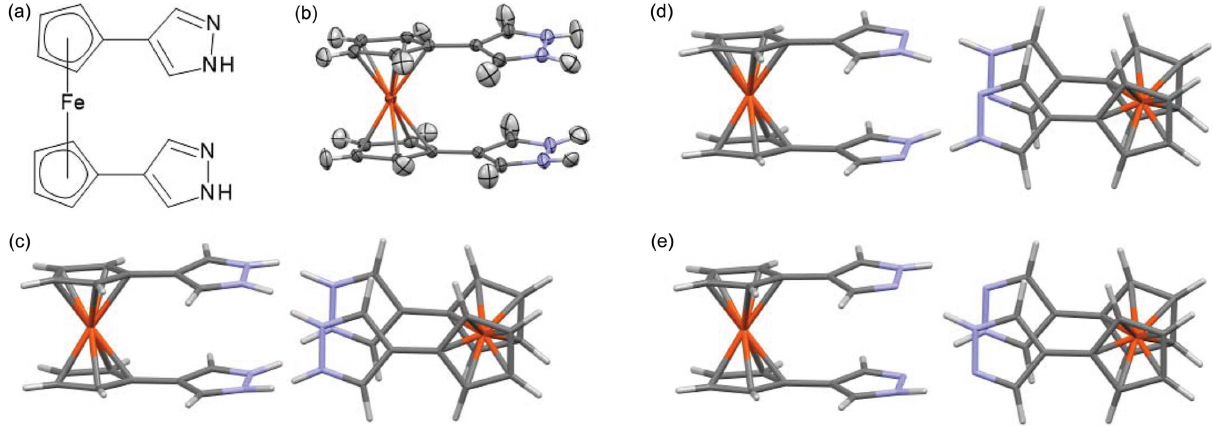
Figure 13 1,10-Bis(pyrazol-4-yl)ferrocene (BECFAT): ( a ) structural formula, ( b ) average structure with two conformations superimposed (HAR refinement), ( c )